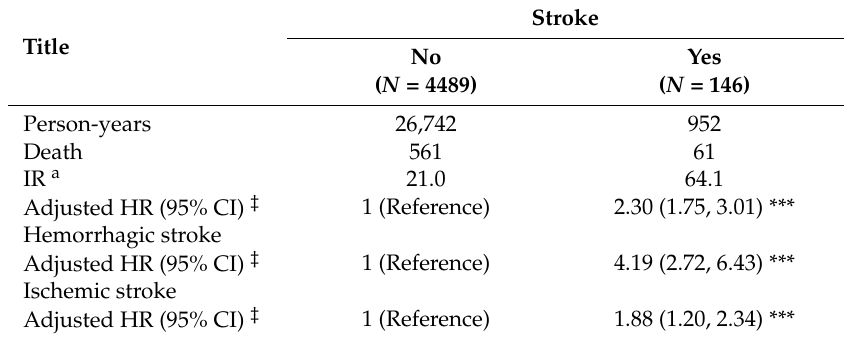
Table 6. Overall death and hazard ratio of death measured for stroke patients among the KT